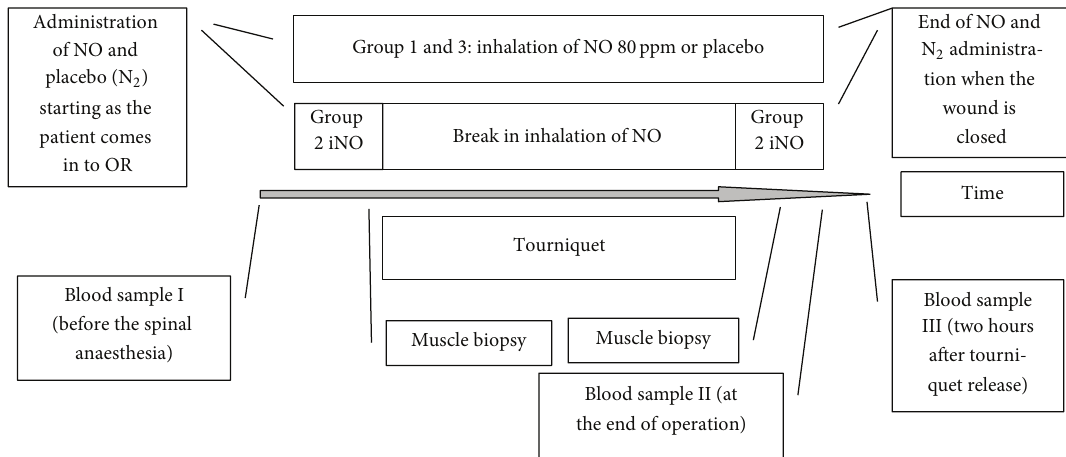
Figure 1: Flow diagram. iNO: inhaled nitric oxide, N 2 : nitrogen (placebo). Groups 1 (iNO) and 3 (placebo) received iNO 80 ppm or placebo (N 2 ) throughout the entire operation. Group 2 (piNO) has a break in NO administration during the period of activated tourniquet and administration of NO restarts approximately 2 minutes before the tourniquet